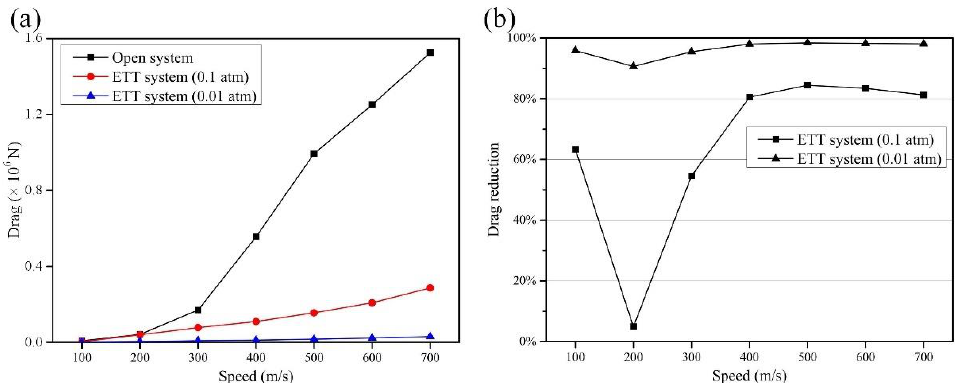
Figure 6. ( a ) Drag of the tube train for the 1 atm open system, 0.1 atm ETT system, and 0.01 atm ETT system from U = 100 to 700 m/s, ( b ) Drag reduction in tube trains compared with the 1 atm open system.